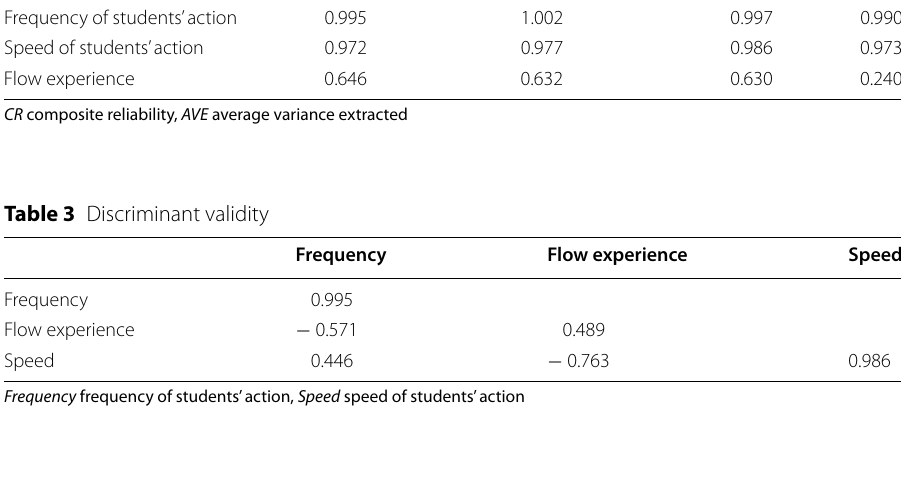
Table 4 Relationship between students’ behavior and their overall flow experience